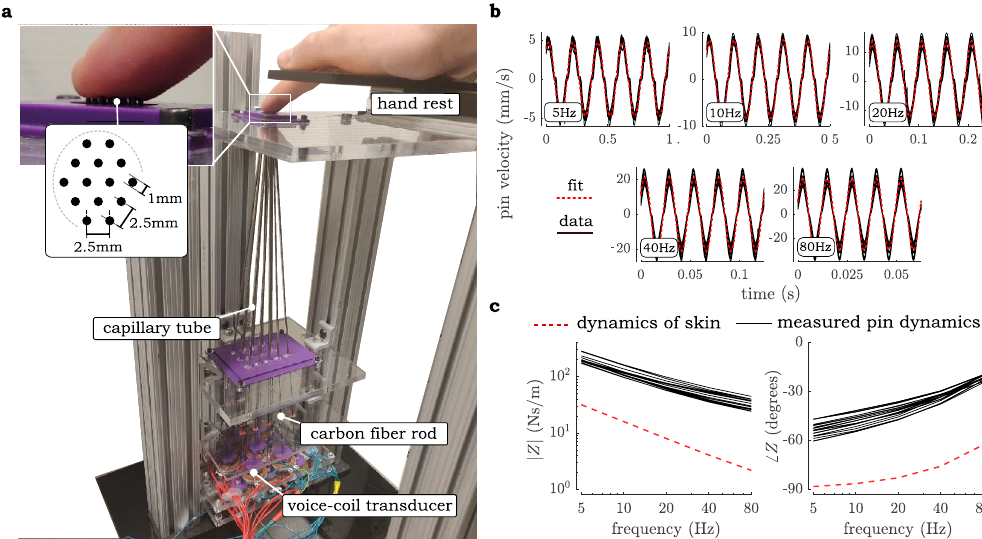
Figure 6. Experiment hardware and its characterization. ( a ) Pin array vibrotactile apparatus used in this study. ( b ) Vertical motion of each of the 14 pins measured by an LDV as they were actuated by sinusoidal currents across the frequency range used in the psychophysical study. ( c ) Measured impedance magnitude and phase of 14 pins relative to that of the finger’s assumed dynamics. Note that the measured pin phase does not appear to be predicted by a linear dynamic model where. ∠ Z ( ω ) | ω → 0 = − 90 due to the nonlinear contributions of static